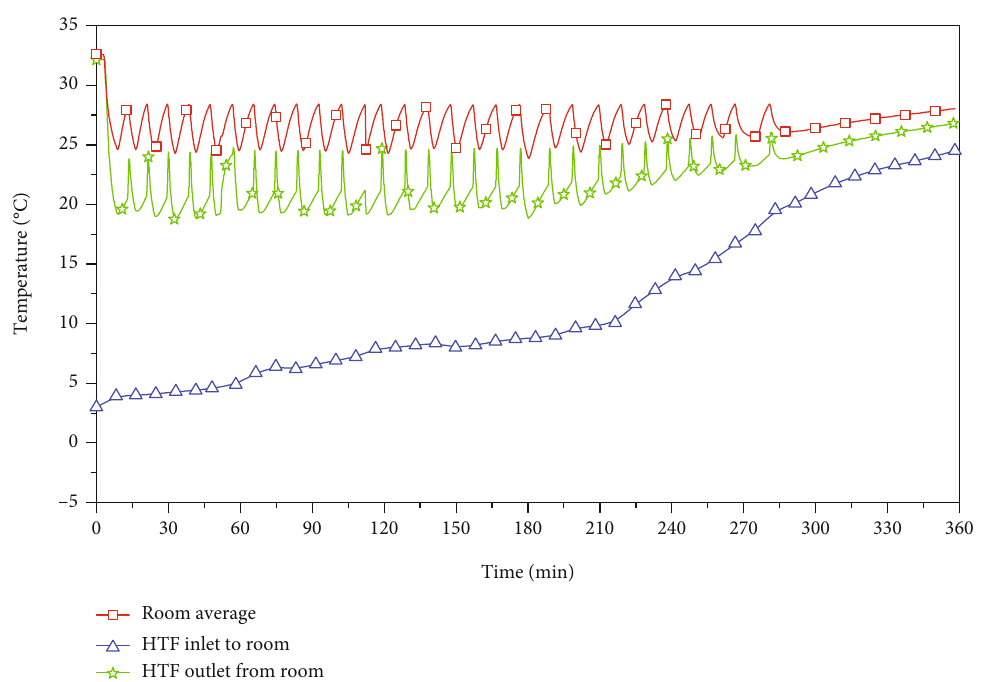
Figure 7: Temperature-time history of the room and the brine inlet/outlet of the cooling coil